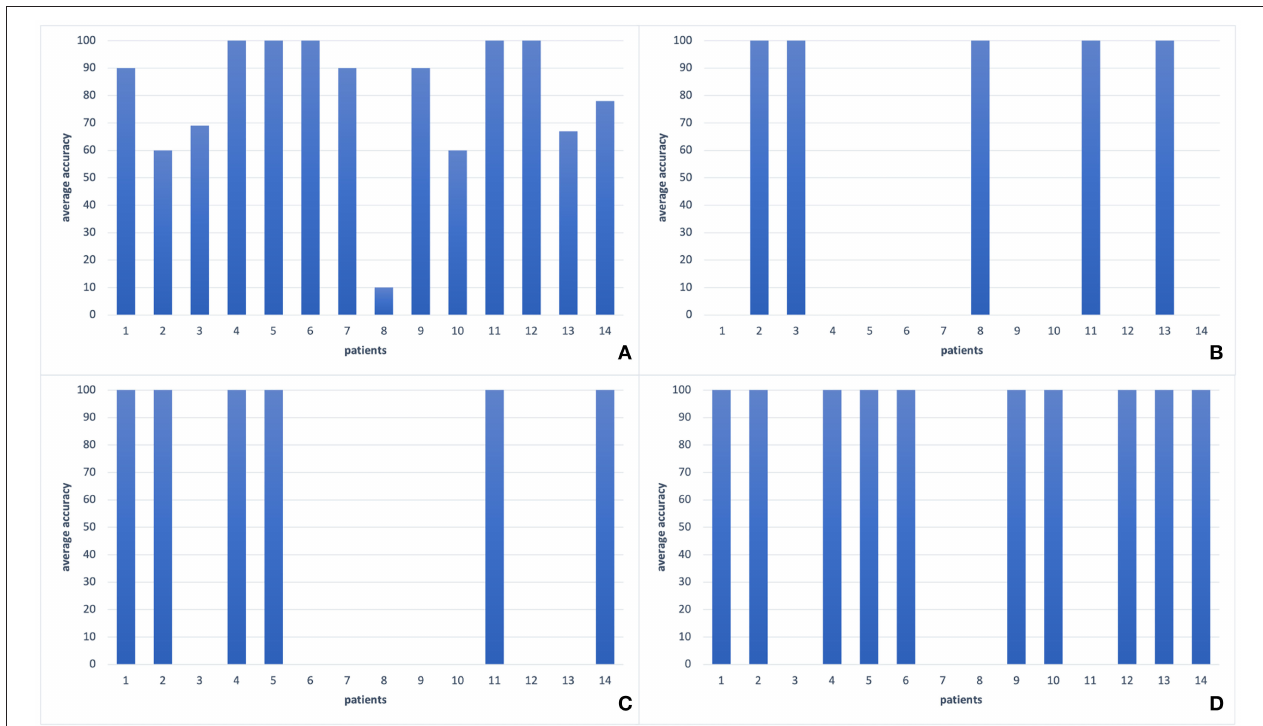
FIGURE 5 | The comparison of different classification methods with leave-one-out validation of EEG2 signals of each patient in our dataset. (A) SVM classifier (78%), (B) SWLDA classifier (36%), (C) EEGNet (43%), (D) Shallow ConvNet (71%). As it is seen, there is a large variance among patients for all classification methods. However, most of the patients form a coherent team whereas two patients’ accuracies are around 60%, and one has an accuracy about 10%. The best two performances can be seen by SVM and Shallow ConvNet.